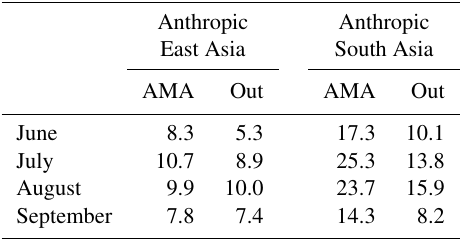
Table 2. Monthly CO from different sources inside and outside of the AMA in ppbv.